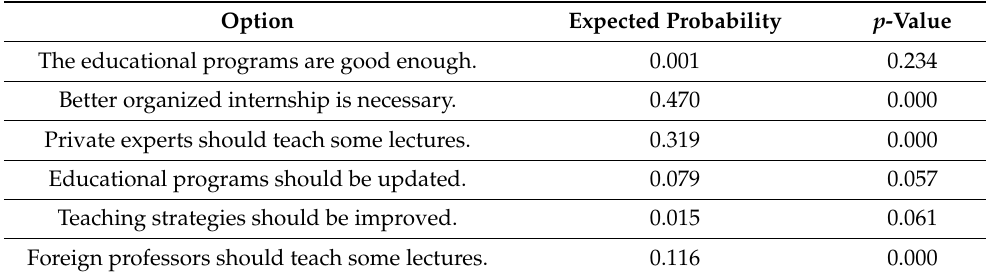
Table 3. Students’ probabilities of ranking first a certain option (expected choice probabilities).